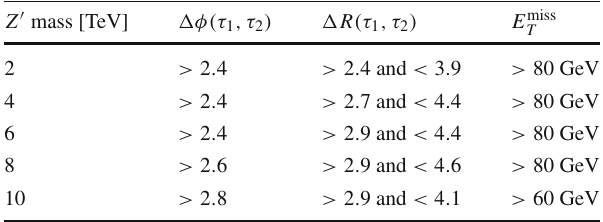
Table 6 Mass dependent cuts optimised to maximise the sensitivity for the Z (cid:2) → ττ resonance